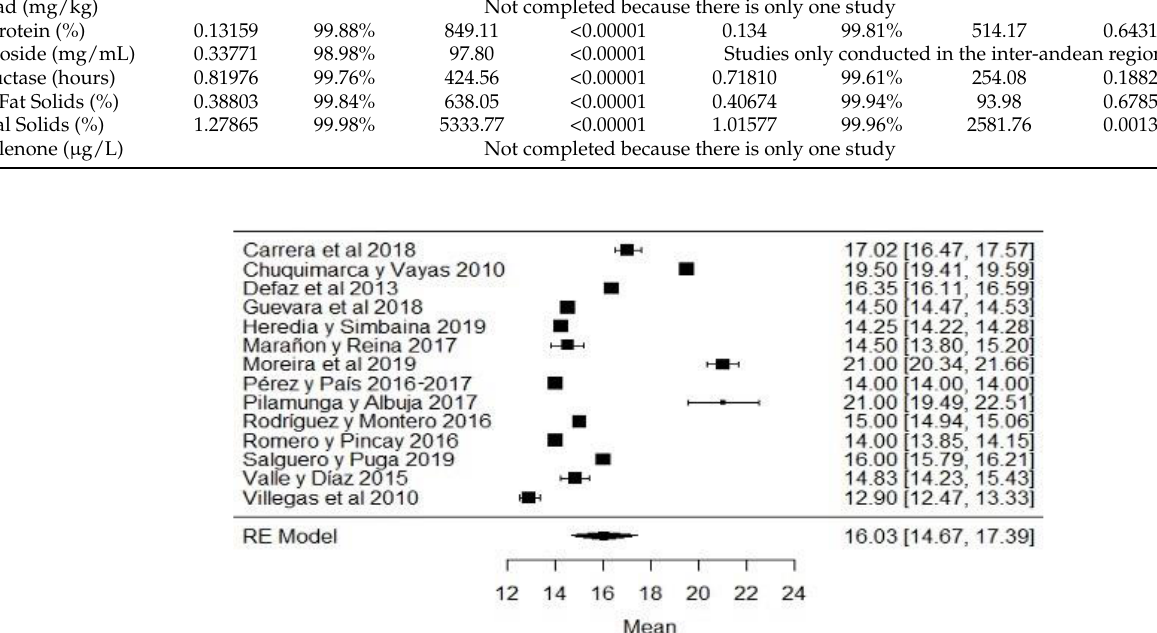
Figure 3. Ash forest plot [18,38,42].